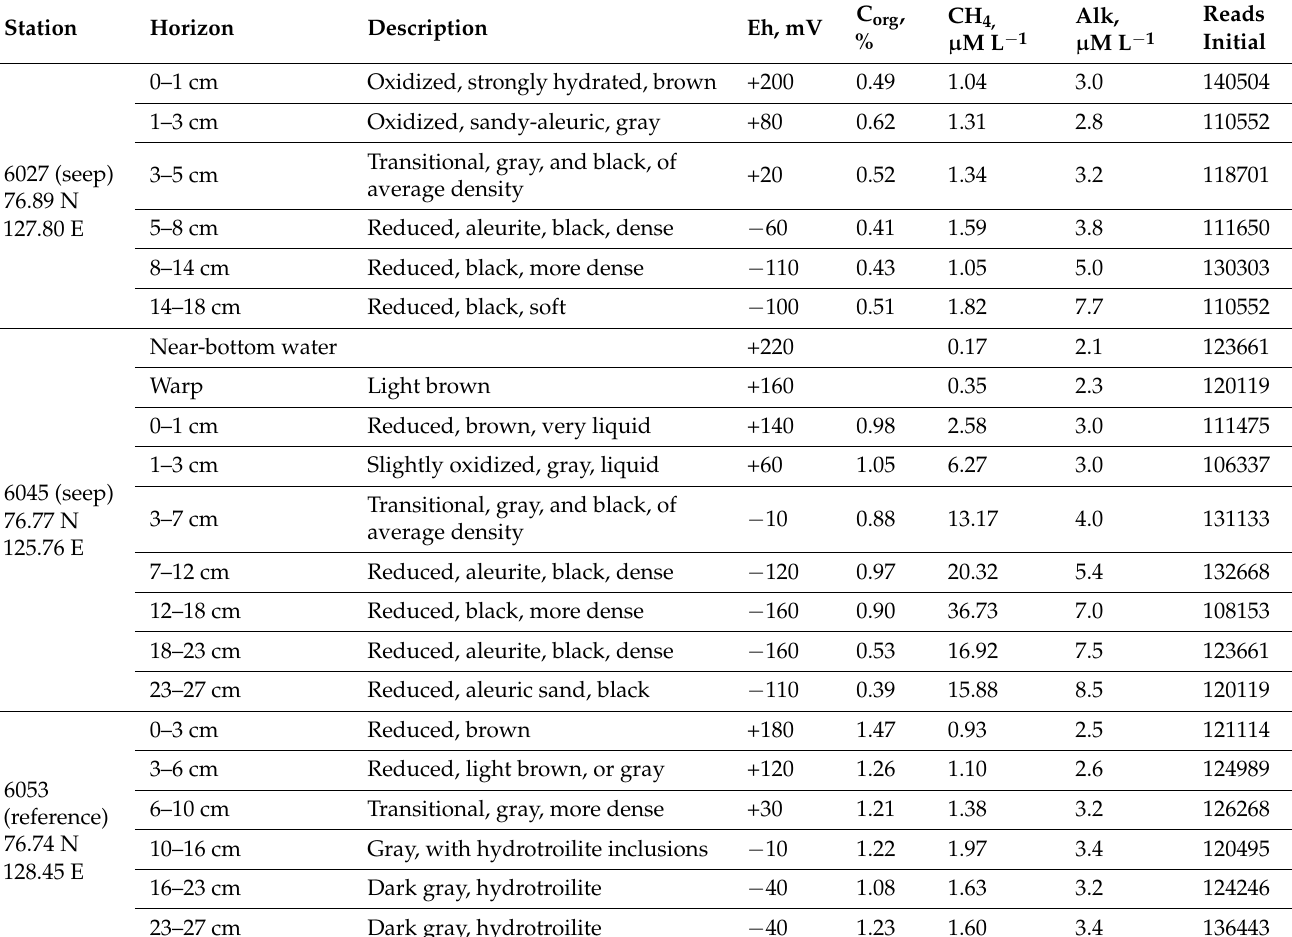
Table 1. General properties of the sediments and number of read sequences of 16S rRNA at three Laptev Sea